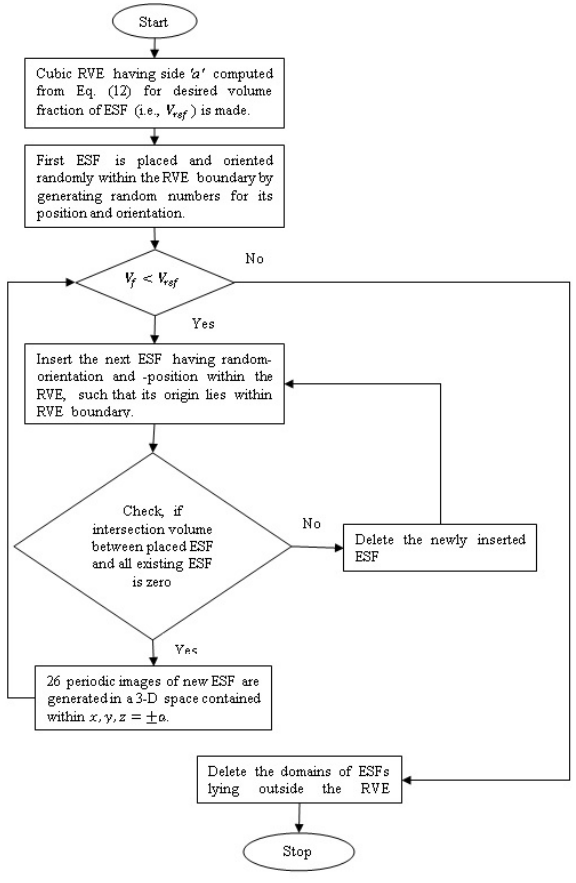
Fig. 3: Boolean based RSA algorithm to generate periodic RVE.